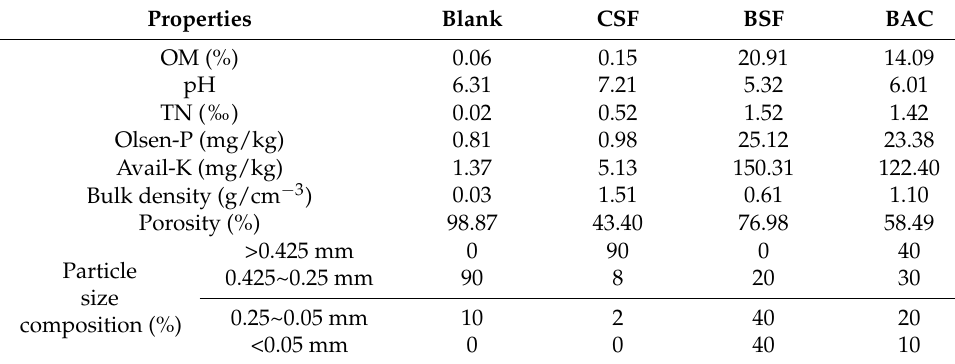
Table 1. Physicochemical properties of sandy soil.